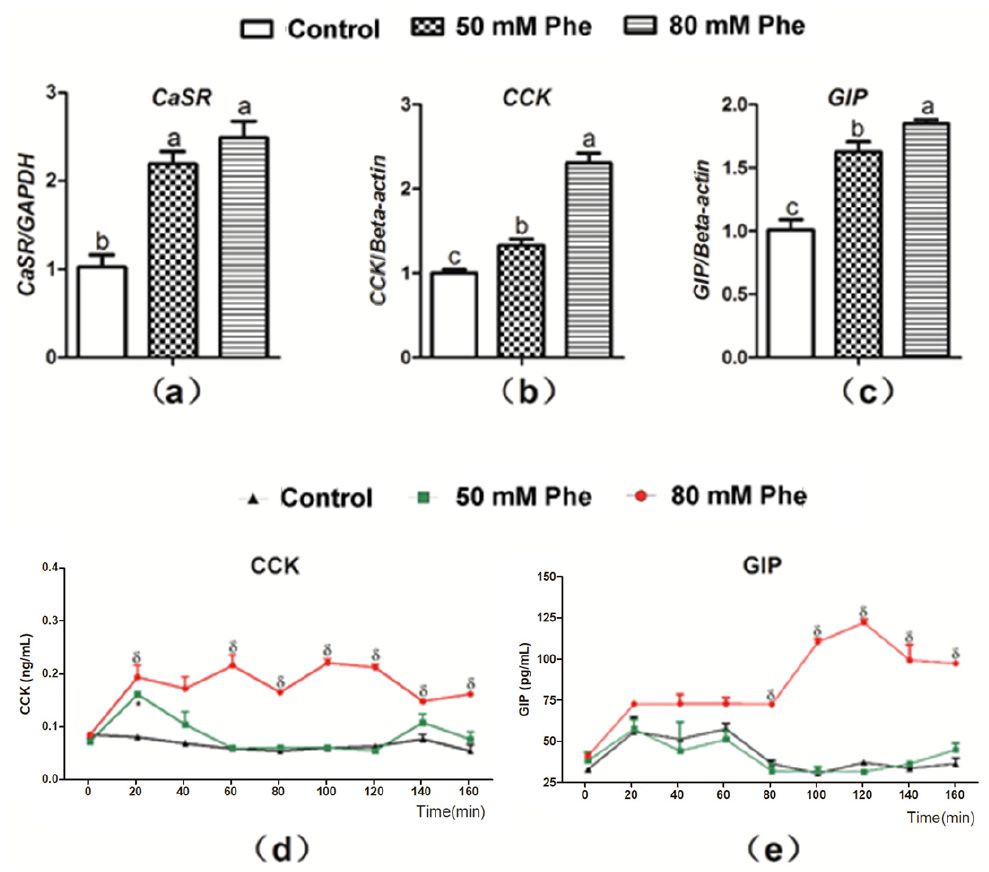
Figure 2. The mRNA expressions of CaSR, CCK, and GIP and the secretion of CCK and GIP in response to Phe in pig duodenum. The tissues were treated with different concentrations of Phe, namely 0 (control group), 50 mM, and 80 mM Phe. After 160 min of perfusion, the relative mRNA expression of ( a ) CaSR, ( b ) CCK, and ( c ) GIP was detected by Real-Time PCR; GAPDH and β -actin were used as internal controls. The concentrations of ( d ) CCK and ( e ) GIP were measured using corresponding ELISA kits every 20 min during the perfusion. Values are presented as mean and SEM ( n = 5). For each gene ( a – c ), means with dissimilar letters show significant difference at p < 0.05. For the same time-points (( d ) and ( e )), significant differences at p < 0.05 are indicated by * and δ for Phe concentrations of 50 mM and 80 mM, respectively, compared with the control group.